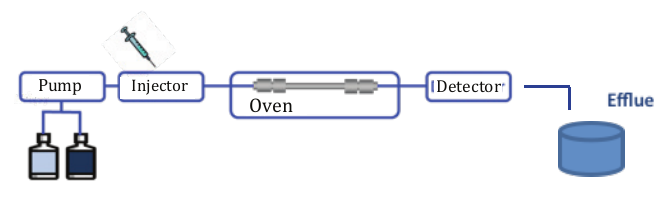
Figure 1: LC instrumentation scheme